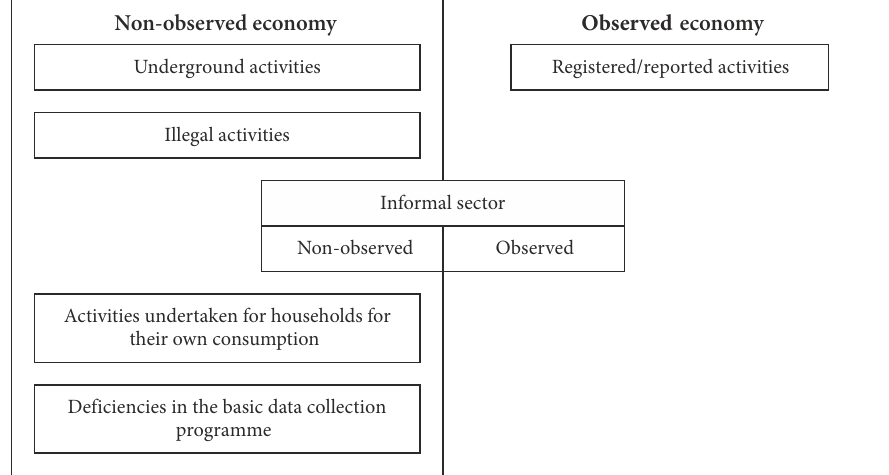
Table 1. Delimiting the “observed” from “non-observed”